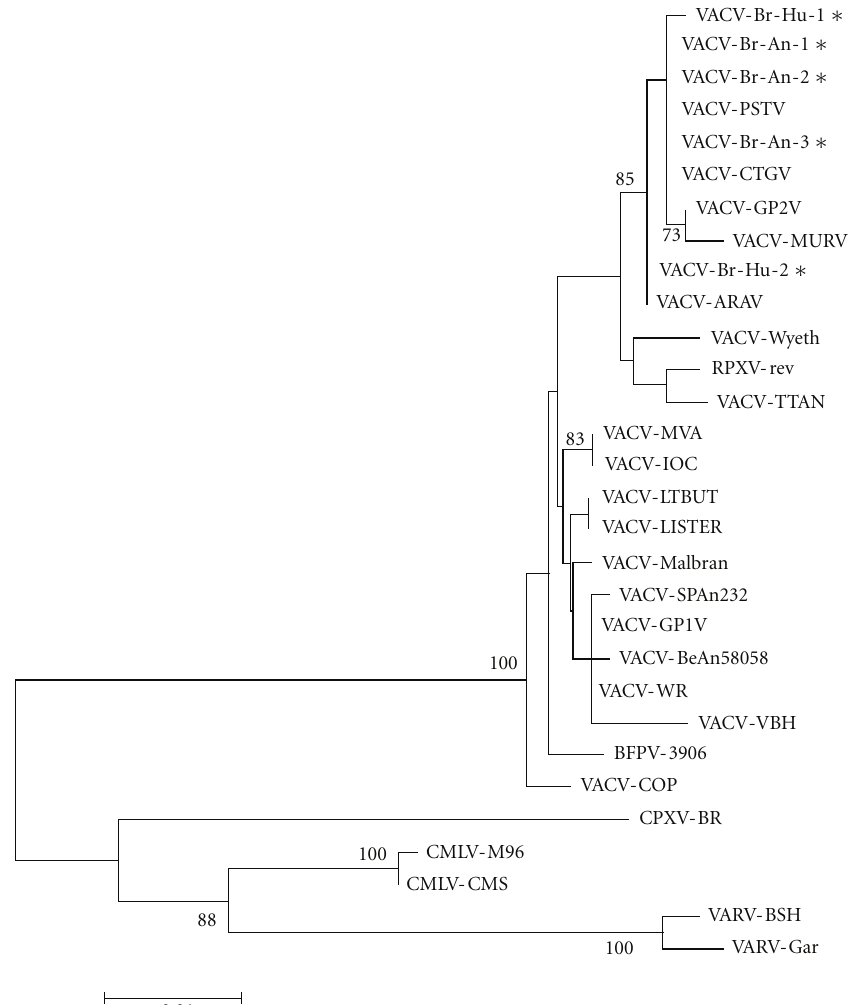
Figure 1: Phylogenetic relationships between the VACV samples obtained in this study and other relevant poxviruses. The phylogenetic tree was constructed by the Neighbor-joining method and used hemagglutinin gene nucleotide sequences from various orthopoxviruses, including Brazilian Vaccinia virus (VACV) isolates and other poxviruses. The Tamura3-parameter nucleotide substitution model was used and the reliability of the branching patterns was tested by 1000 bootstrap pseudo-replicates. Bootstrap values above 70% are shown. The scale bar represents 1% nucleotide sequence divergence. Samples are as follows: Zoonotic Brazilian Vaccinia virus isolated from humans (VACV-Br-Hu-1, VACV-Br-Hu-2) or cattle (VACV-Br-An-1, VACV-Br-An-2, VACV-Br-An-3)—labeled with stars ( ∗ ); other Vaccinia virus strains isolated in Brazil—Passatempo (VACV-PSTV), Cantagalo (VACV-CTGV), Arac¸atuba (VACV-ARAV), Guarani P2 (VACV-GP2V) (DQ206437), Muria´e (VACV-MURV), VACV-BeAn58058, Belo Horizonte (VACV-VBH), VACV-SPAn232, Guarani P1 (VACV-GP1V); reference Vaccinia virus strains—Western Reserve (VACV-WR), VACV-Lister, Modified virus Ankara (VACV-MVA), Copenhagen (VACV- COP), VACV-Wyeth, VACV-TTan, VACV-Malbran, Lister Butantan (VACV-LTBUT); VACV-IOC (AF229248), Bu ff alopox virus (BFPV- 3906) (AF375077); other Orthopoxviruses—Cowpox virus Brighton Red (CPXV-BR), Rabbitpox virus rev (RBPV-rev), Ectromelia virus Moscow (ECTV), Camelpox virus CMS (CMLV-CMS), Camelpox virus M-96 (CMLV-M96), Variola virus Garcia-1966 (VARV-GAR), and Variola virus Bangladesh-1975